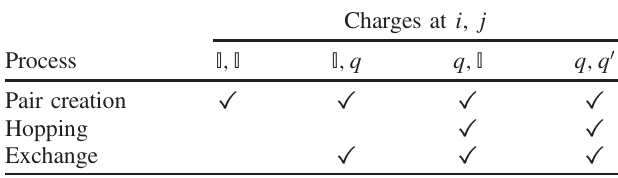
TABLE I. Allowed elementary noise processes for our phe- nomenological noise model of anyon dynamics. The check marks denote allowed processes on a directed edge i → j of the underlying graph G , and q , q 0 denote nonvacuum anyon charges.